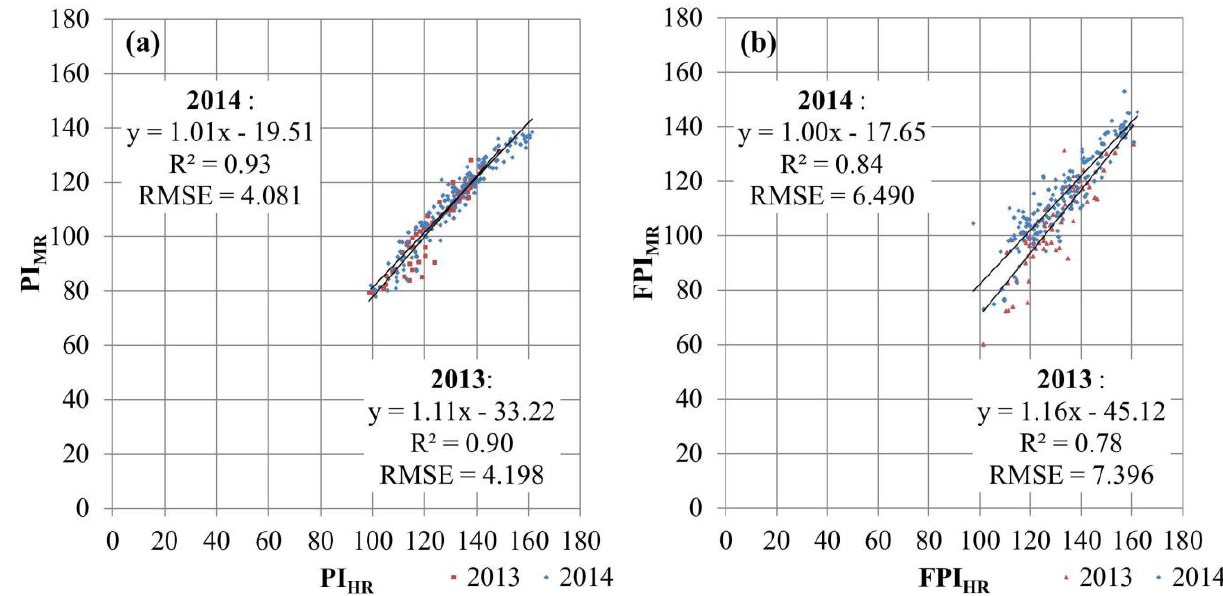
Figure 9. ( a ) Scatterplots of the Production Index (PI) and ( b ) Forage Production Index (FPI) derived from high resolution (HR) and moderate resolution (MR) images of 2013 and 2014. While PI indicates overall productivity without land cover distinction, FPI exclusively focuses on productivity in grassland.The HR and MR index values shown were obtained from 69 and 173 ESUs, respectively in 2013 and 2014. RMSE = Root Mean Square